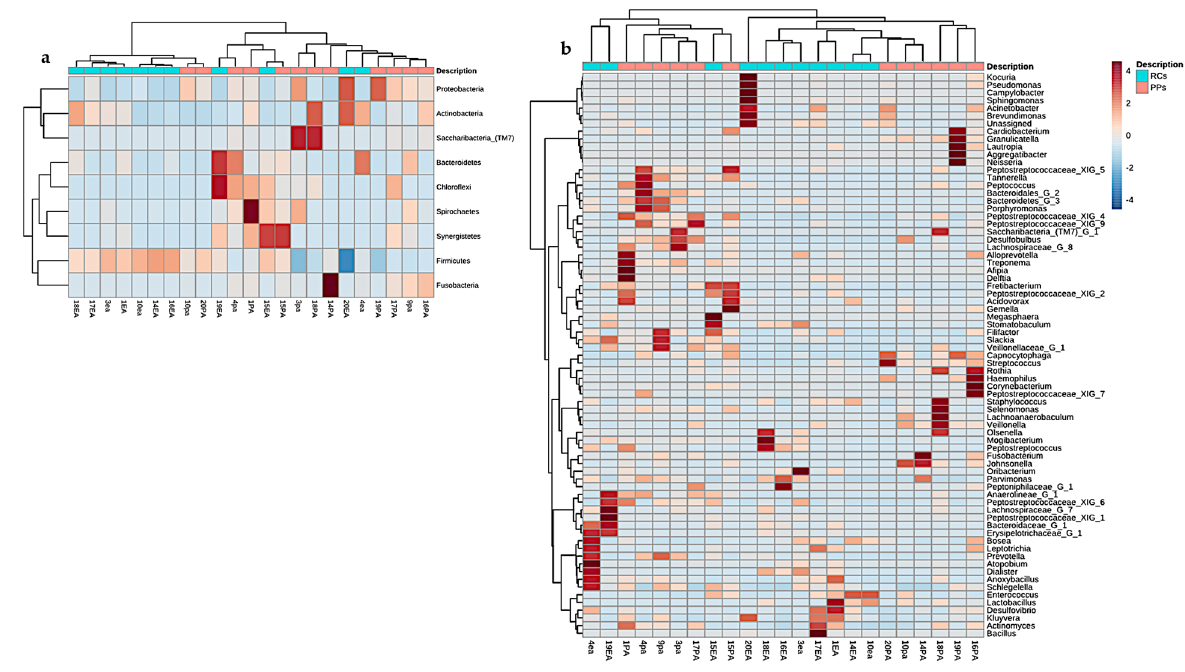
Figure 6. Heatmap containing similarities of the ( a ) phyla ( b ) genera in root canals and periodontal pockets. Red bars represent categories of phyla with the highest prevalence in the 12 samples of each site analyzed with a diversity pipeline.